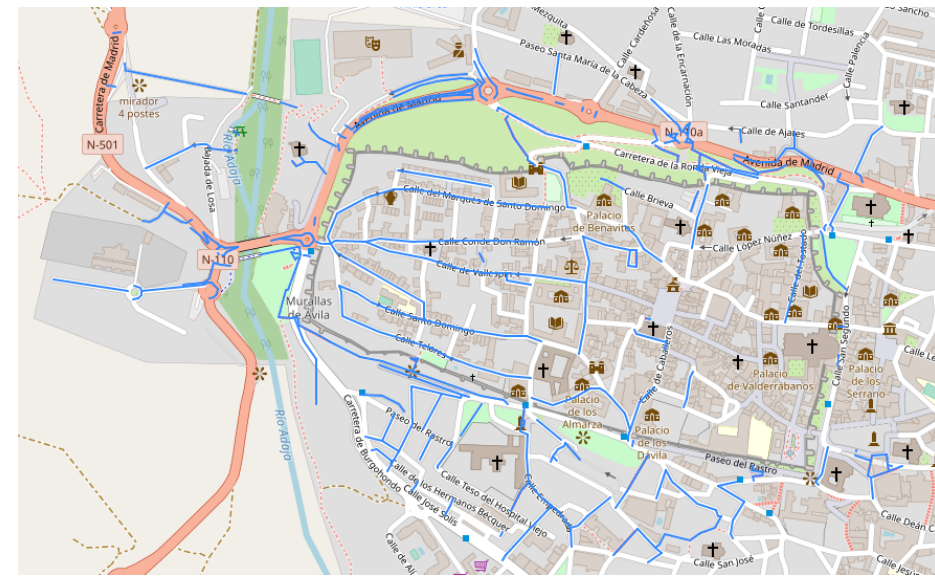
Figure 4. Inaccessible streets. In blue, we show all streets that can not be accessed by people with important mobility problems (e.g., people with wheelchairs), that corresponds with the red color level in Table 3.